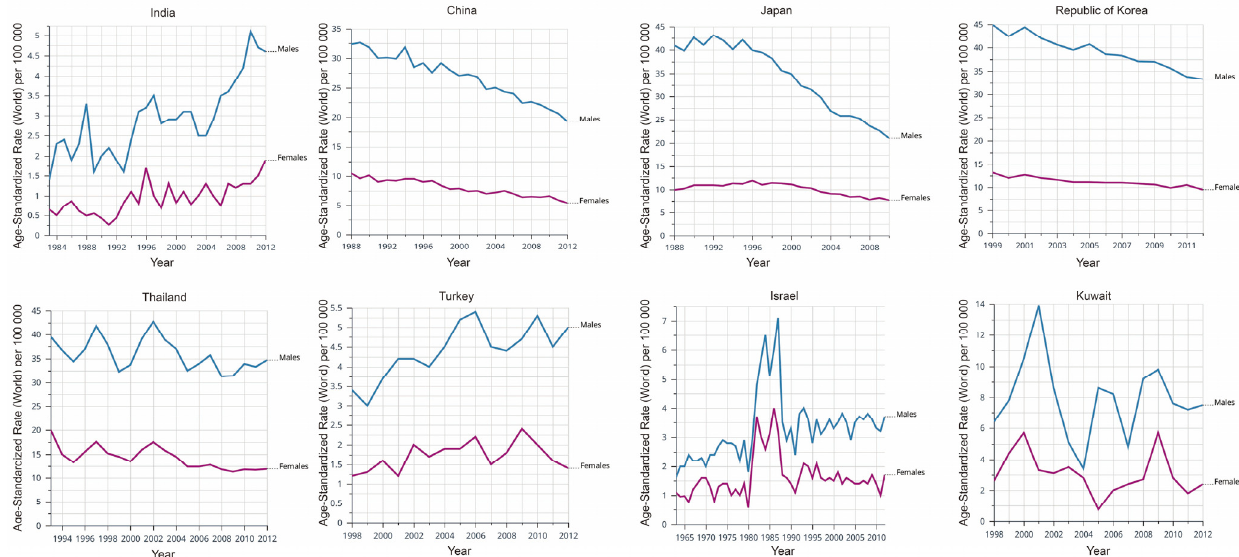
Figure 1. Dynamic changes of the incidence of liver cancer in different Asian countries, based on CANCER OVER TIME|IARC (International Agency for Research on Cancer). Data are presented as incidence per 100,000.